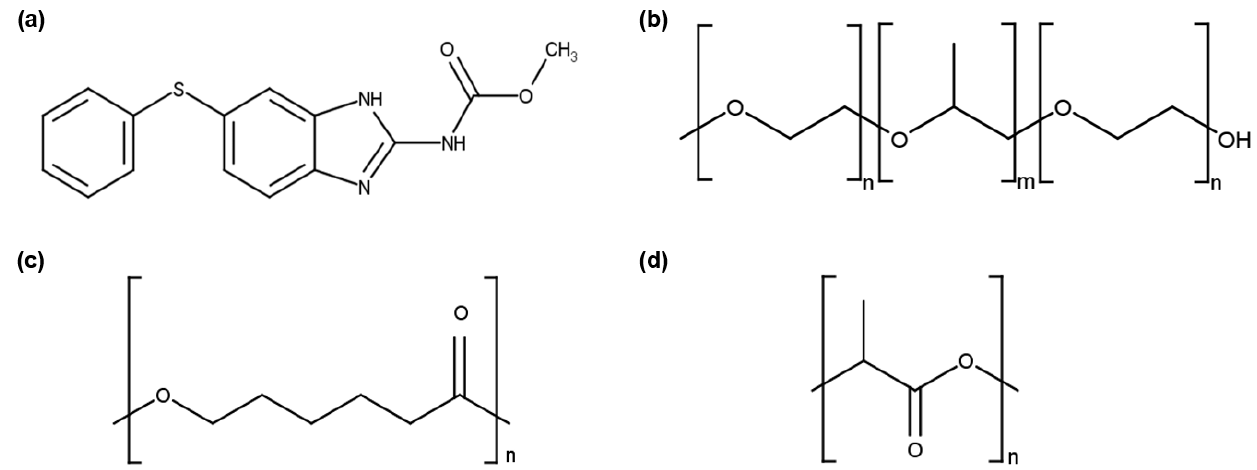
Figure 1. Chemical structures of ( a ) Fen, ( b ) P 407, ( c ) PCL, and ( d ) PLA designed using MarvinSketch 15.4.6.